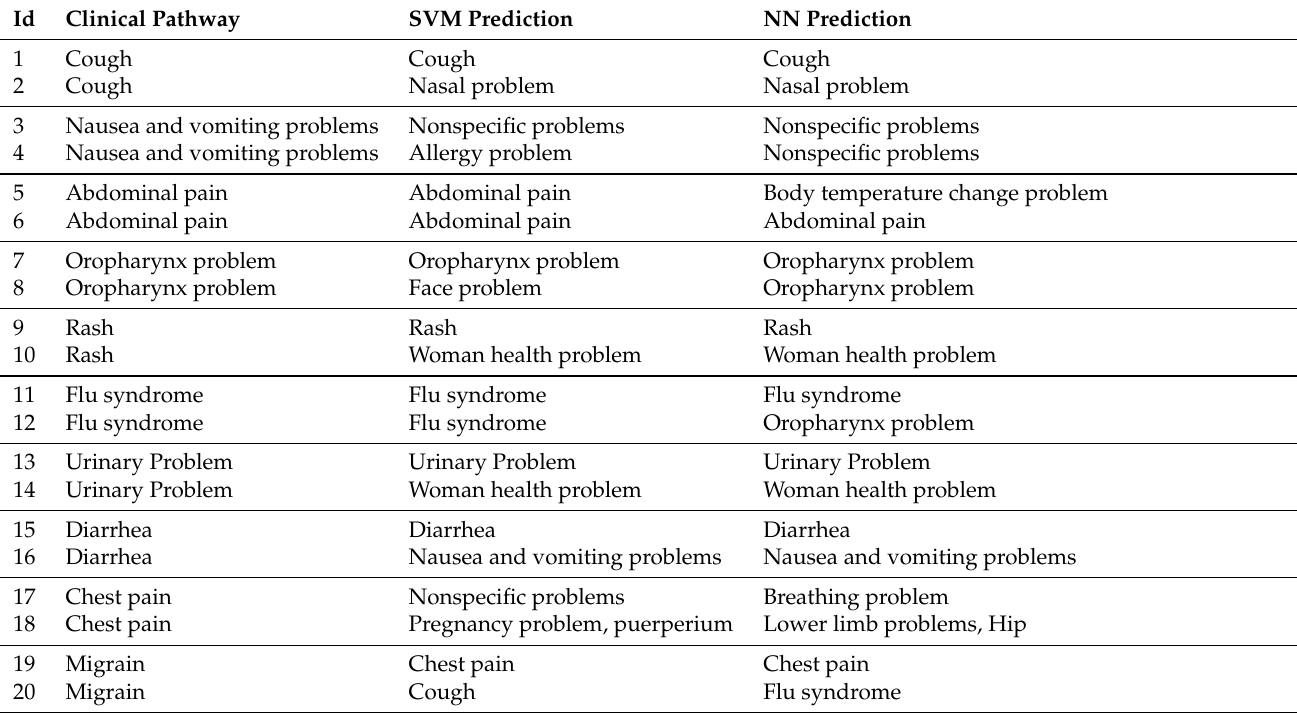
Table A3. Examples and corresponding clinical pathways and labels predicted by SVM (Support vector machines) and NN (Neural